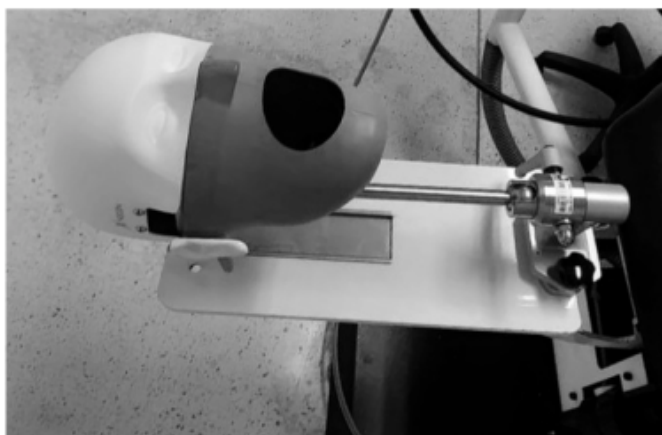
Figure A1. NISSIM Type 1 Dental simulator (NISSIN Dental Products Inc., Kyoto, Japan) attached to